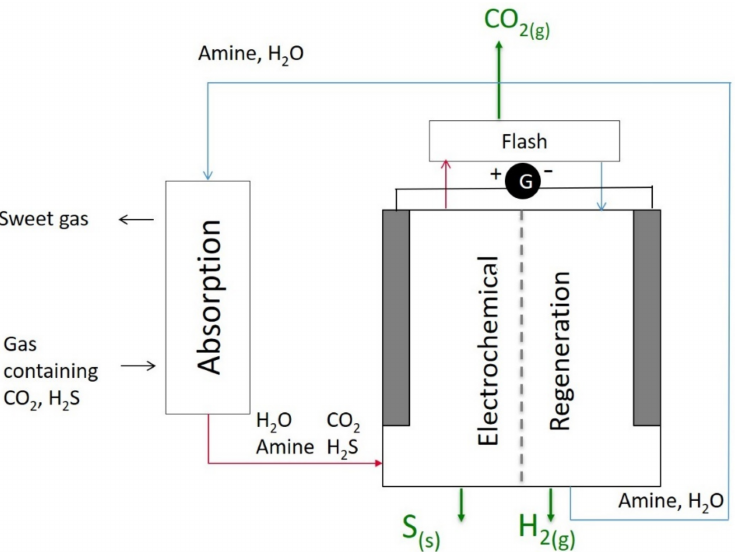
Figure 2. A schematic diagram of the overall acid gas removal, separation, and conversion process consisting of an absorption column and an electrochemical solvent regeneration cell.